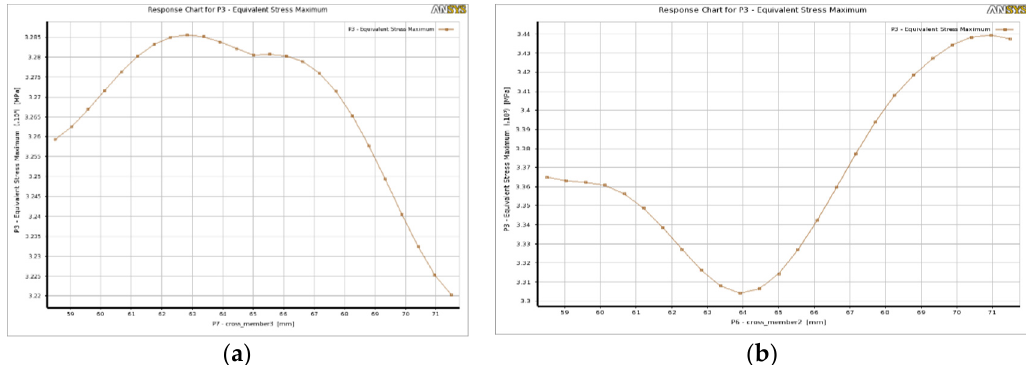
Figure 21. ( a ) Equivalent stress vs. cross member, ( a ) 3 in case of CCD scheme, and ( b ) 2 in case of optimal space filling design.